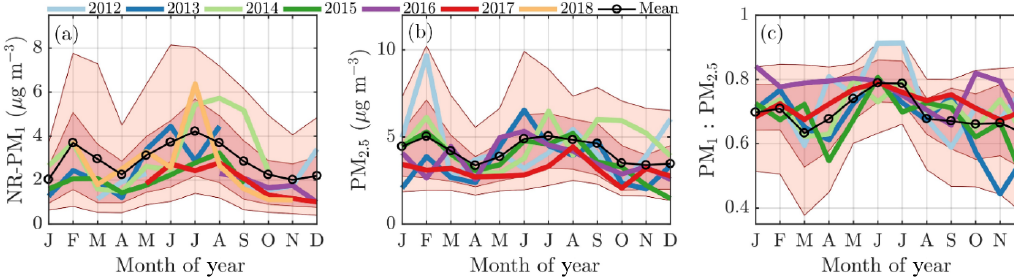
Figure 3. The monthly cycles of NR-PM 1 (a) , PM 2 . 5 (b) , and the ratio between PM 1 and PM 2 . 5 (c) . The median monthly values for each year are individually displayed with the colored solid lines. The circled black line represents the overall monthly mean values. The shaded dark red area is drawn between the overall 25th and 75th percentiles and the shaded lighter red area is drawn between the overall 10th and 90th percentile. The x axes represent the time of the year and the y axes in panels (a) and (b) represent mass concentration in µgm − 3 and a unitless ratio in (c) .